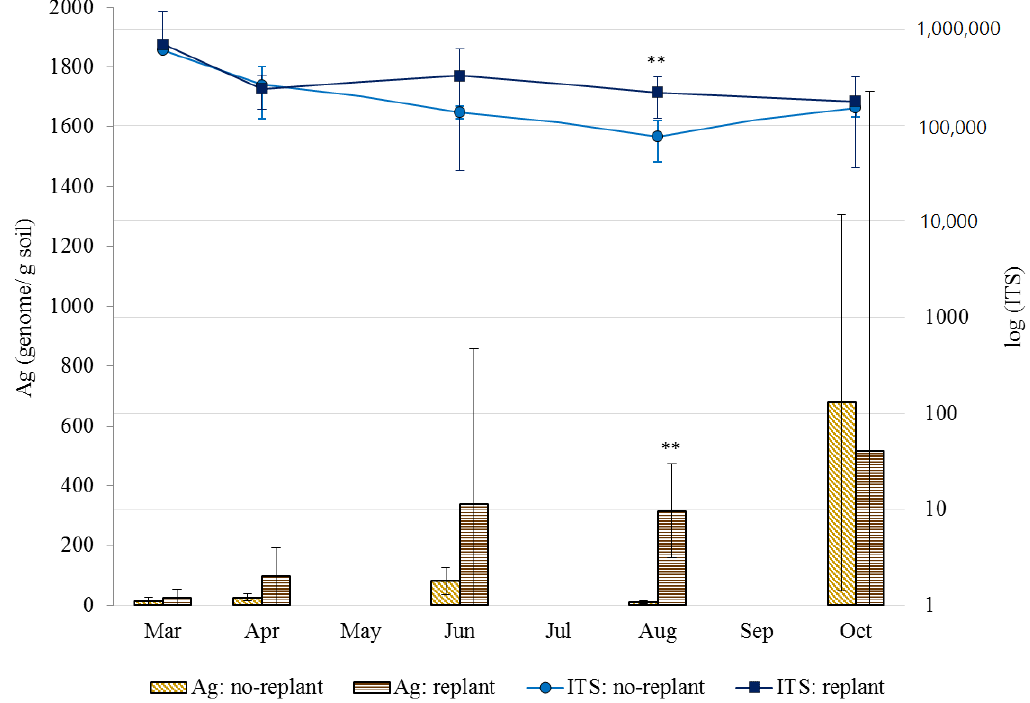
Figure 1. Concentration of Alternaria -group (Ag) (genome / g soil) and total fungal DNA (log (ITS)) in no-replant soil (nr) and replant soil (r). Significances calculated between nr and r soil. α = 0.05, ** p ≤